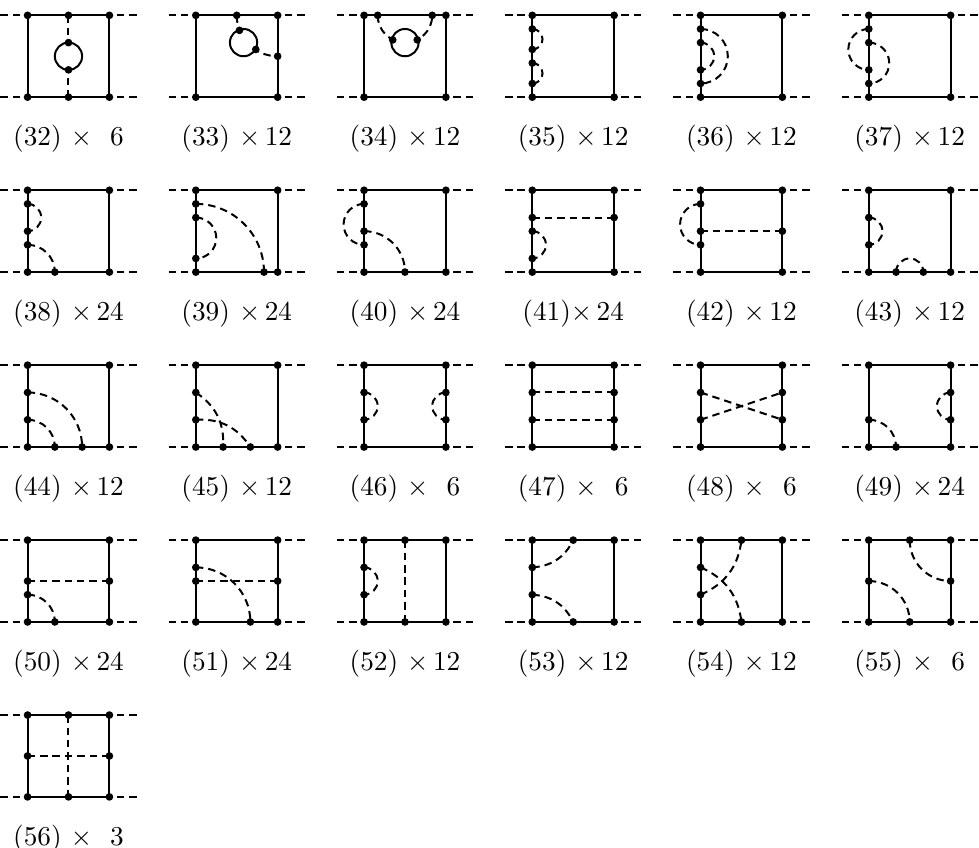
Figure 5 . Three-loop diagrams contributing to the scalar quartic vertex renormalisation, contain- ing only Yukawa couplings with a single fermion loop (solid lines) and scalar propagators (dashed lines) propagators. The number of inequivalent permutations of external legs is listed below each